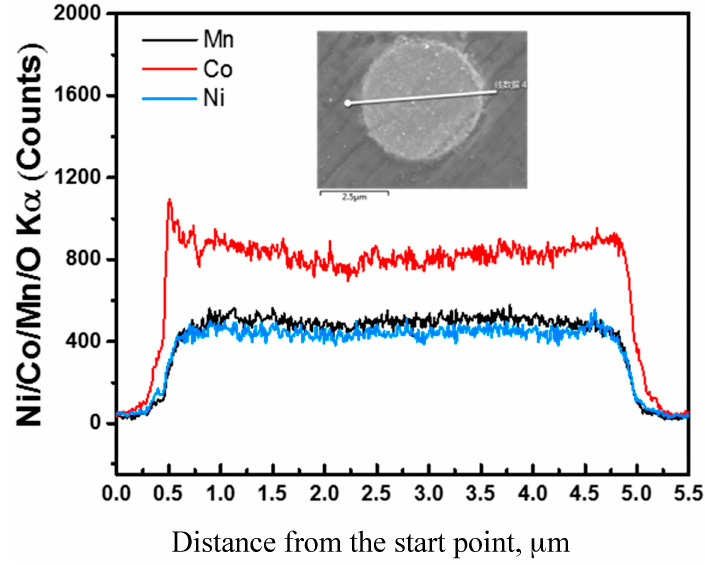
Figure 11. The EDS images of the particles with a core-shell structure.